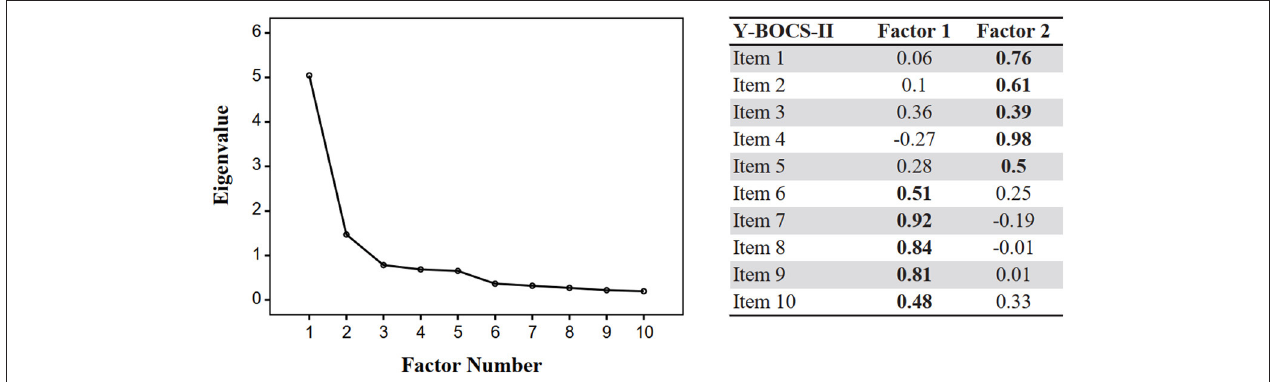
FIGURE 1 | Scree plot (exploratory factor analysis) and pattern matrix for Y-BOCS-II factors in the OCD sample. In the pattern matrix, standardized weights of a regression analysis in which item responses are predicted from their levels of the underlying factors are represented. Factor loadings above 0.4 or highest factor loading shown in bold.